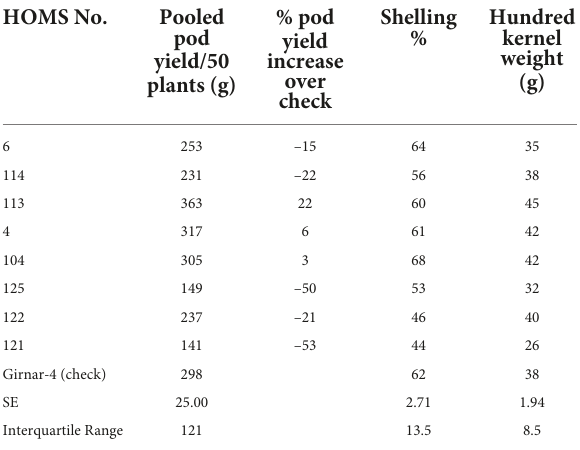
GJG32 (check) SE TABLE 6 Pooled pod yield over two seasons of Virginia bunch (VB) high oleic breeding lines and percent increase of pod yield over check. HOMS No. Pooled pod